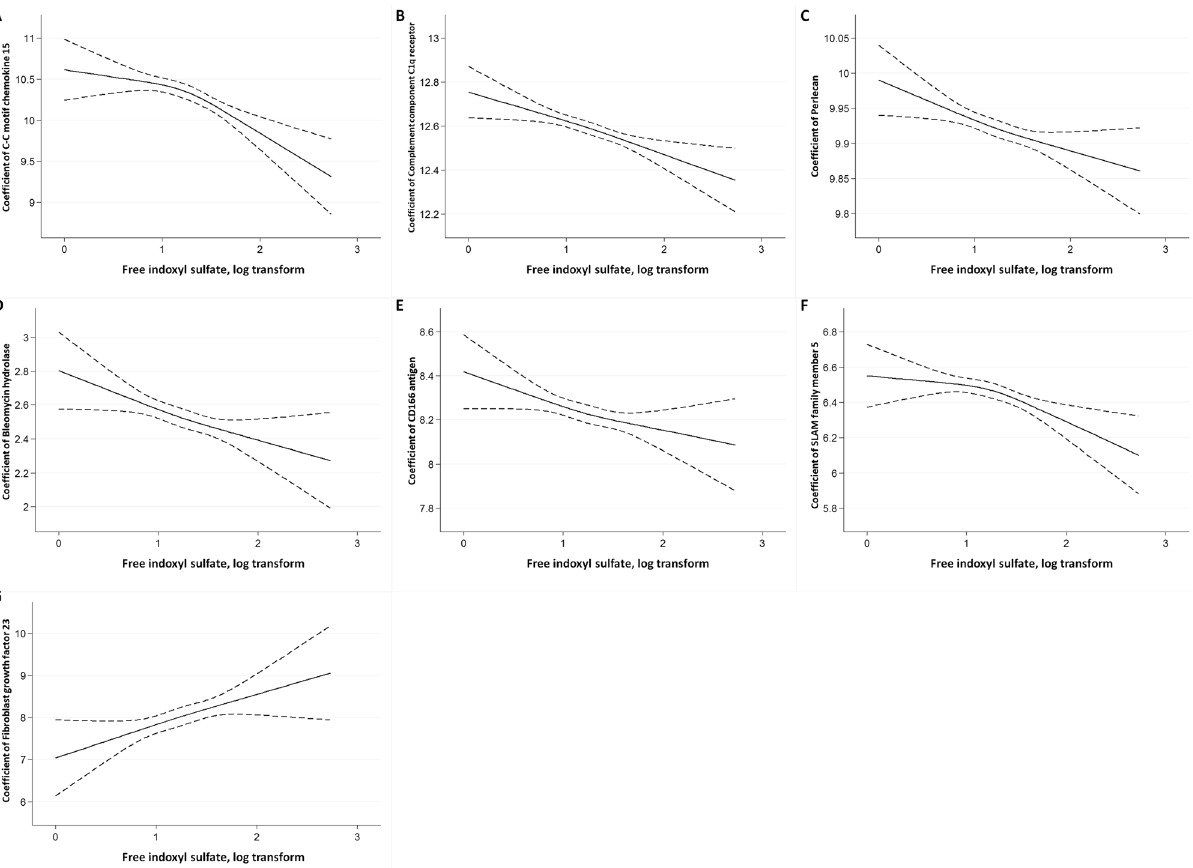
Figure 3. The cubic spline curve between the log-transformed indoxyl sulfate concentration with 3 knots and selected circulating cardiovascular protein biomarkers NPX units ( A ) C–C motif chemokine 15 (CCL15) ( B ) Complement component C1q receptor (CD93) ( C ) Perlecan ( D ) Bleomycin hydrolase ( E ) CD166 antigen ( F ) SLAM family member 5 (CD84) ( G ) Fibroblast growth factor 23